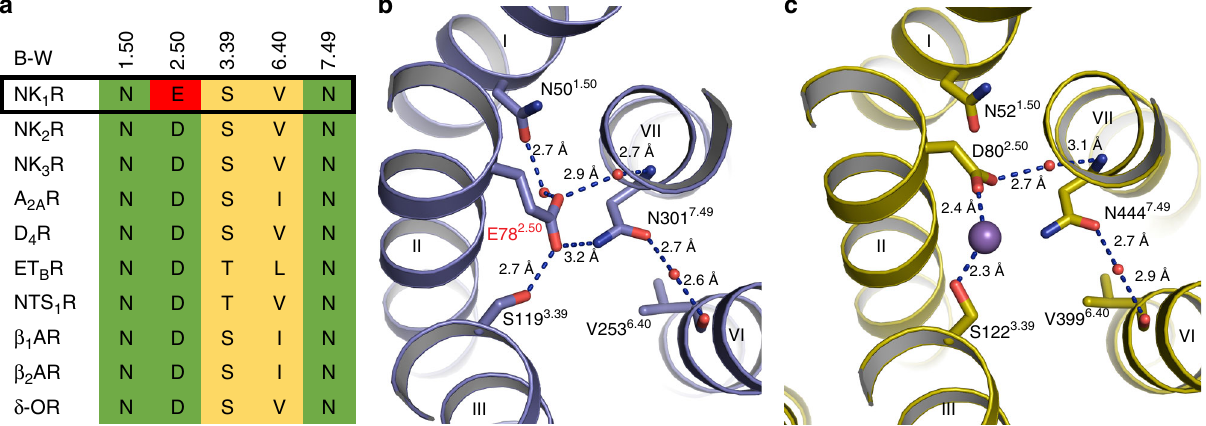
Fig. 4 E78 2.50 -mediated interhelical hydrogen-bond network in the transmembrane core. a Amino acid sequence alignment of residues involved in the allosteric sodium ion-binding site in NK 1 R and other class A GPCRs (Ballesteros-Weinstein numbers indicated). b , c Extracellular view on the hydrogen- bonding network in the transmembrane core of netupitant-bound NK 1 R ( b ) and the dopamine D4 receptor (D 4 R, PDB ID 5WIV) ( c ). The receptor backbone is shown in ribbon representations coloured blue and yellow, respectively. Ordered waters are shown as red spheres and hydrogen bonds are indicated by dashed blue lines. The sodium ion coordinated between D 2.50 and S 3.39 in the D 4 R is shown as a purple sphere NATURE COMMUNICATIONS| (2019) 10:17